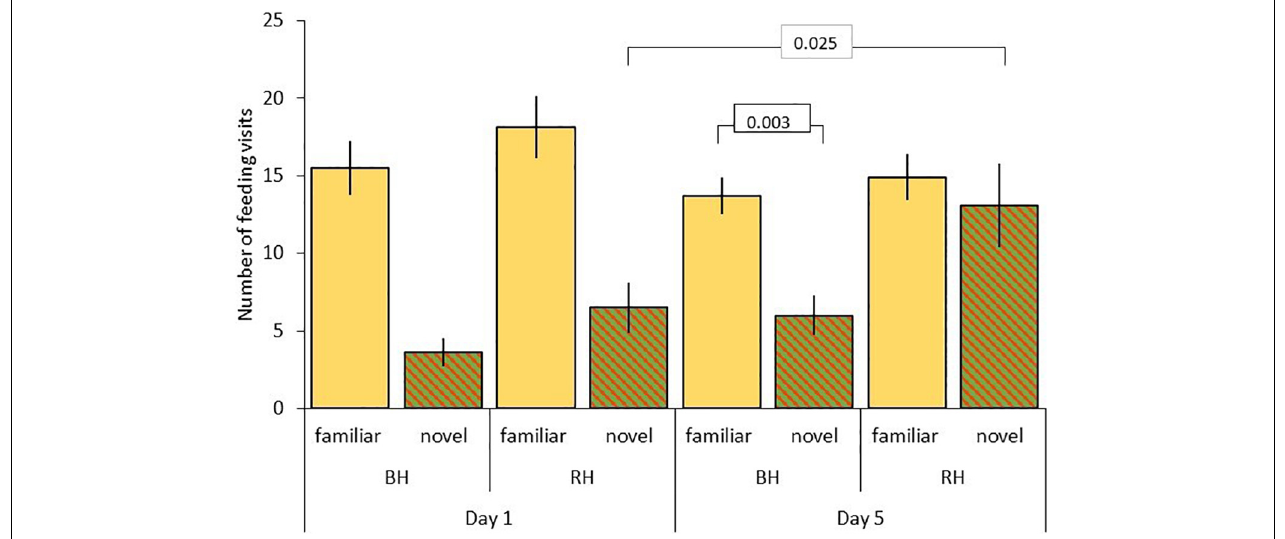
FIGURE 4 | Number of feeding visits after first feed (mean ± SE) to familiar (beige) and novel food (red/green hatched) on day 1 and 5 for red-headed (RH) and black-headed (BH) Gouldian finches. Numbers in the figure represent p -values.